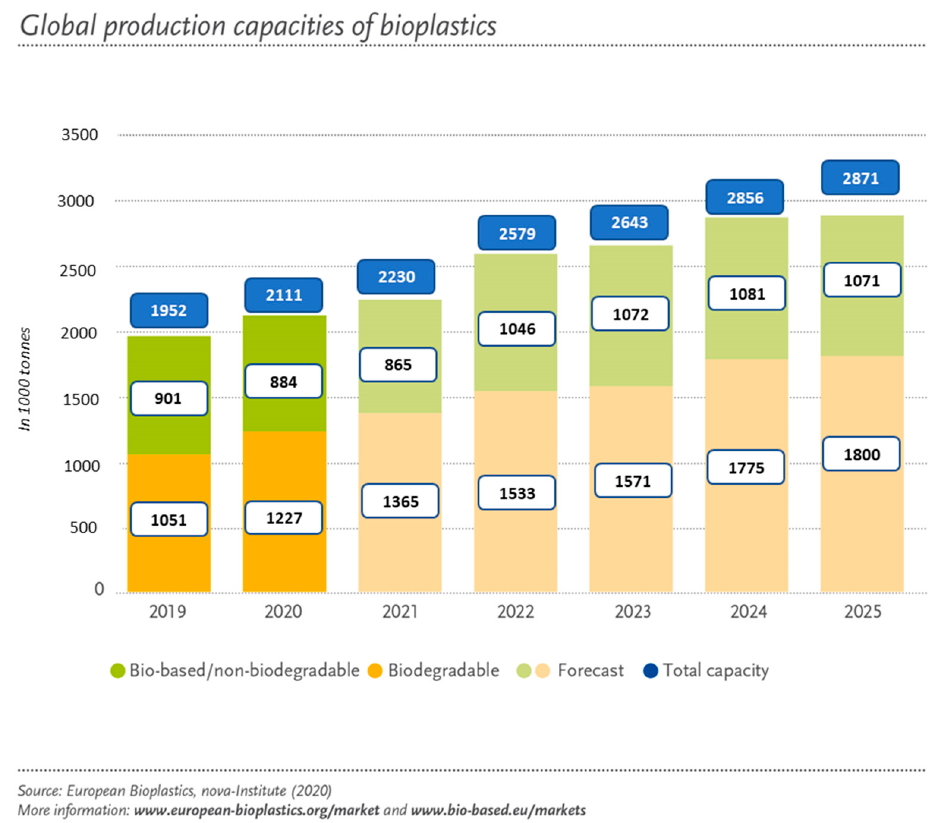
Figure 3. Expected demand for bio-based materials [19] (accessed on 5 March 2021).